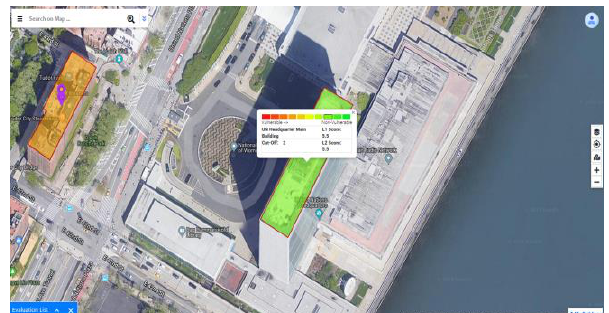
Figure 1. The vulnerability of building and estimation of risk